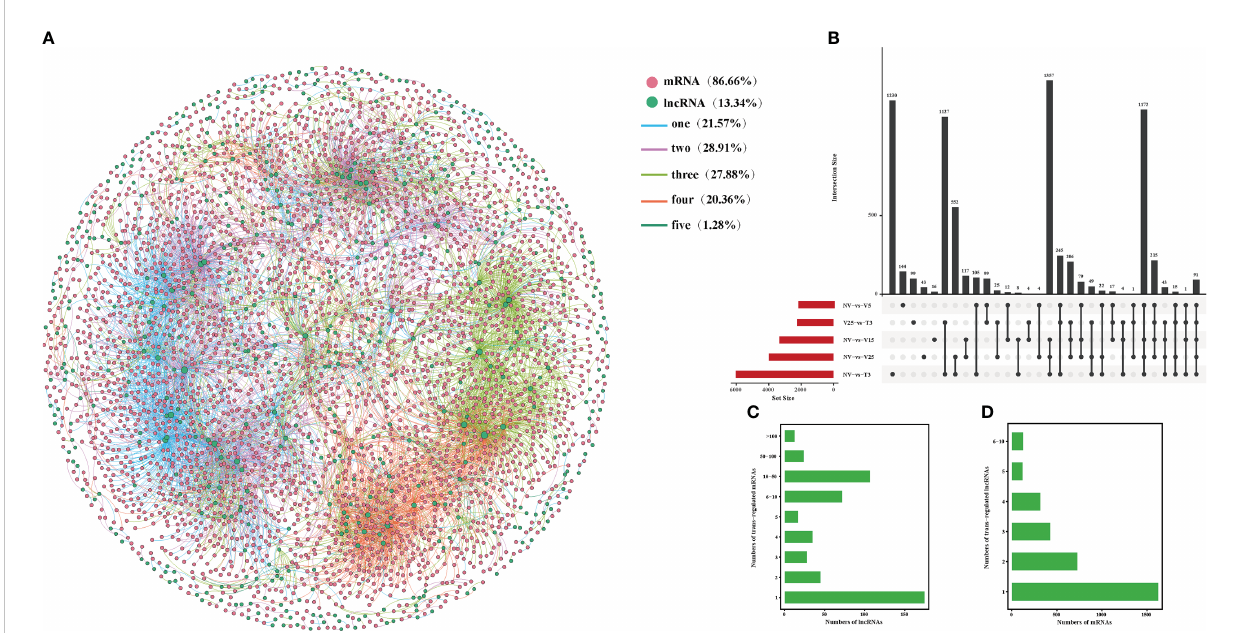
FIGURE 6 Interactions between DE lncRNAs and trans-regulated DE mRNAs during plumule-vernalization in Chinese cabbage. (A) The DE lncRNA – mRNA interaction network of fi ve comparisons (NV-vs-V5, NV-vs-V15, NV-vs-V25, NV-vs-T3, and V5-vs-T3). The nodes represent the mRNAs (red) and lncRNAs (green). The size of the node is positively related to the number of mRNAs (lncRNAs) associated with lncRNAs (mRNAs). The color of the line indicates that a relationship exists in several comparison groups (1/2/3/4/5). (B) Venn diagram showing the number of matched lncRNA – mRNA pairs in different comparisons. (C) The number of DE mRNAs regulated by DE lncRNAs. (D) The number of DE lncRNAs that have potential trans- regulatory effects on DE